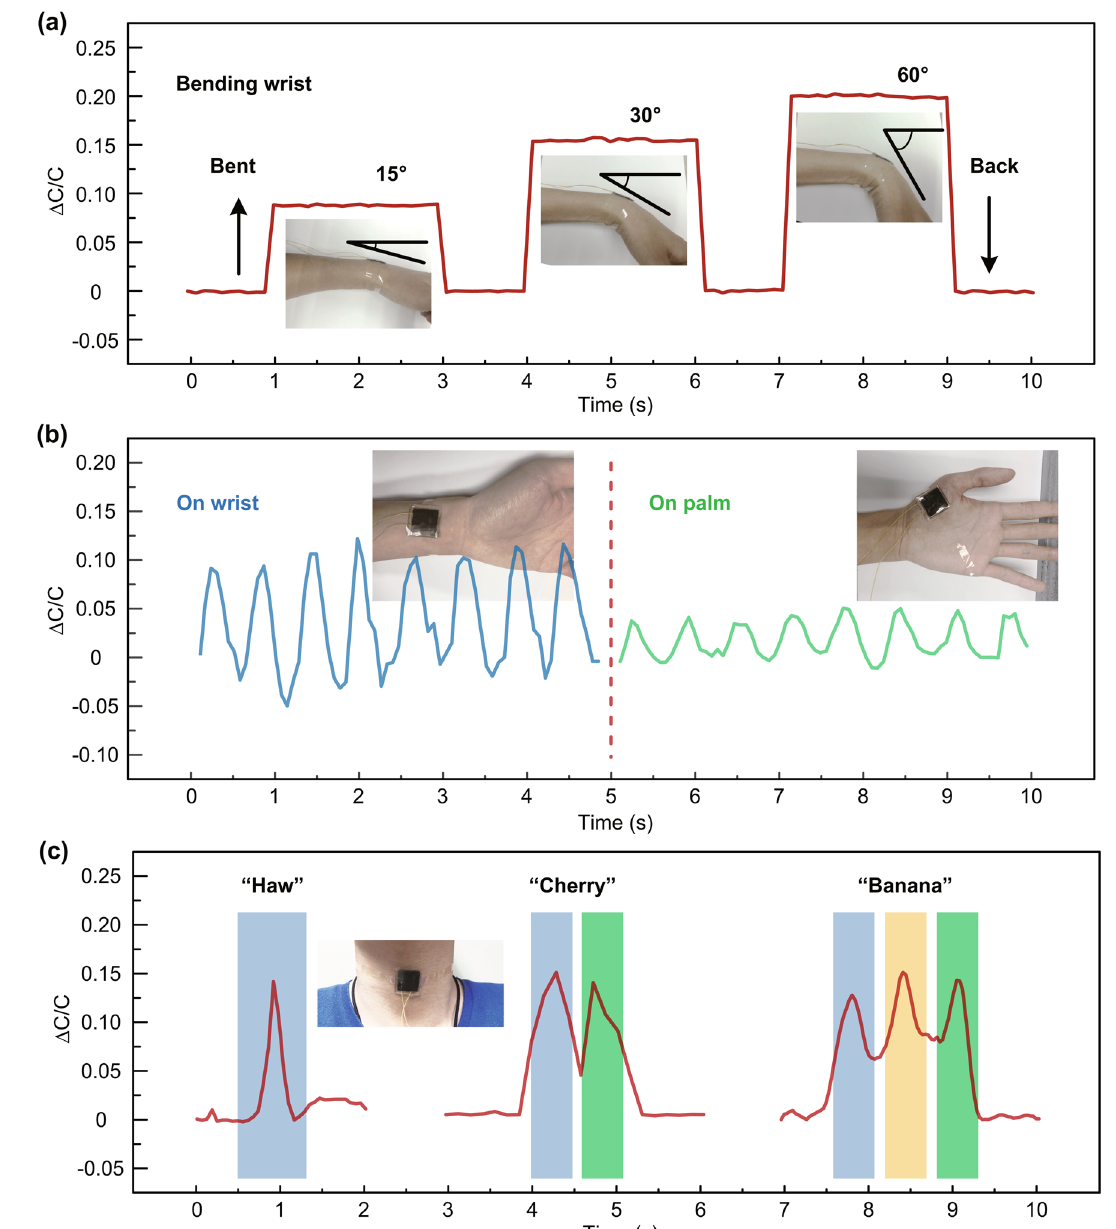
Fig. 4 Application of the wearable sensor. a Capacitance response plot obtained from the sensor when wrist bents with different angles. b Capacitance response of the sensor on the bloodstream in the wrist and the palm. c Transient response of the flexible sensor to speaking vibra‑ tions under the pronunciation of “haw,” “cherry,” and